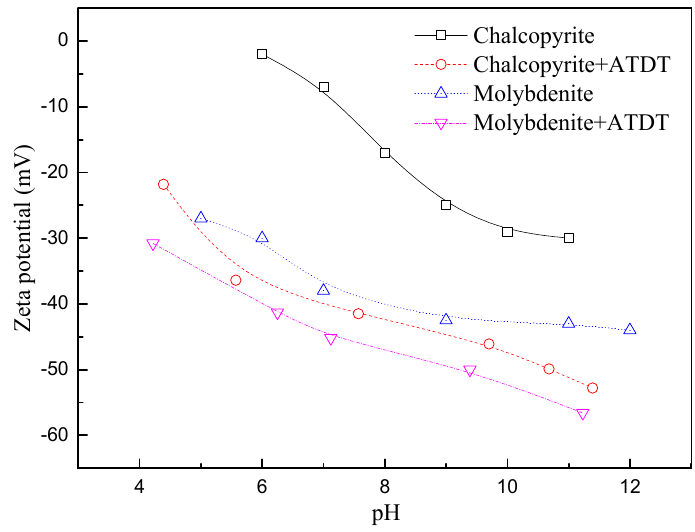
Figure 6. Zeta potential of chalcopyrite and molybdenite as a function of pH in the presence and absence of depressant (C = 2 × 10 − 4 mol/L).